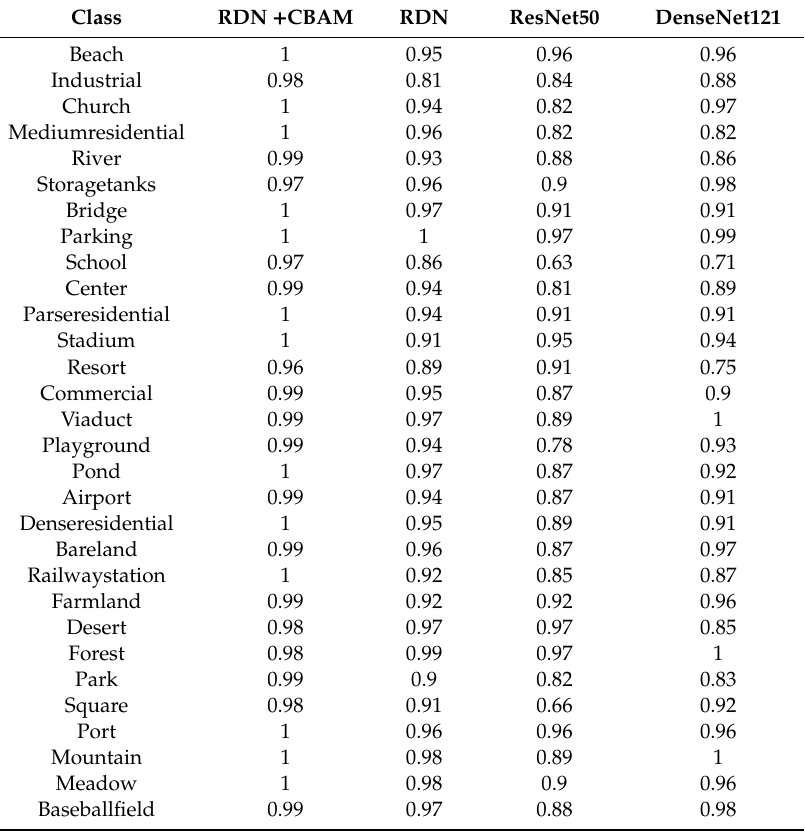
Table 4. Classification accuracy in each category of RDN + CBAM, RDN, Resnet50, Densenet121 on the AID